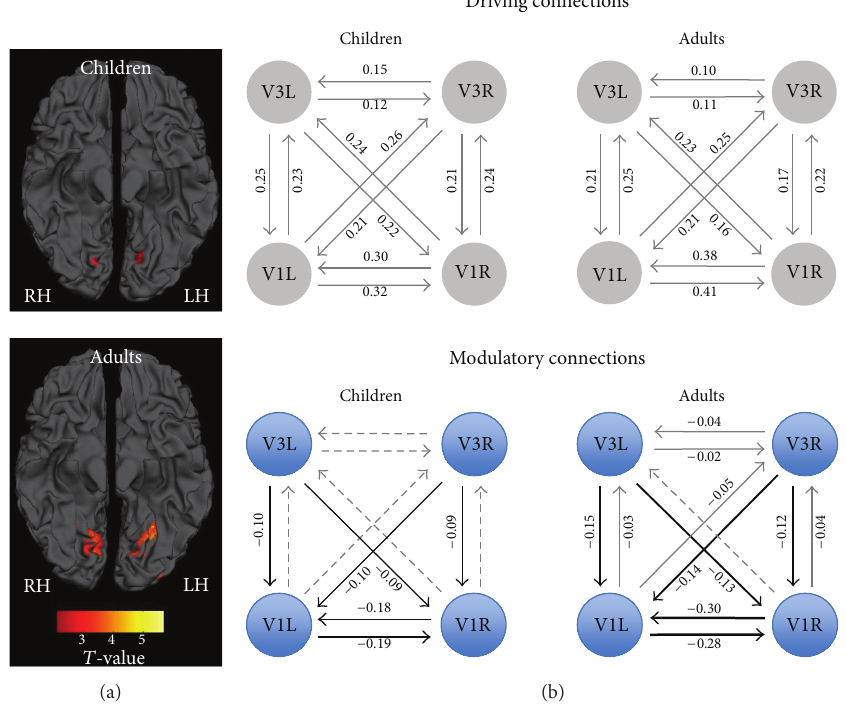
Figure 2: Interhemispheric integration effects as revealed by fMRI activation and dynamic causal modeling. (a) Statistical maps of the CG > NG contrast for the children and adults groups superimposed on a pial surface of a standard brain in MNI space (bottom view). In both groups, an increase of BOLD response is located within the lingual/fusiform gyri, but in the adults it is higher and more extensive. The center of each cluster served to define the V3 location for DCM analysis in each group. (b) Intrinsic and modulatory connections in children and adults. Gray/blue-filled circles symbolize the brain regions involved in the modeled network. They are located in the left and right primary visual cortex (V1L and V1R, resp.) and in the left and right V3v (V3L and V3R, resp.). Arrows between the circles stand for the bidirectional intrinsic/modulatory connections. Dashed arrows designate nonsignificant connections; gray arrows, significant but not changing with age; black arrows, significant and changing with age. The average estimate of the strength of connection in Hertz is shown alongside the respective